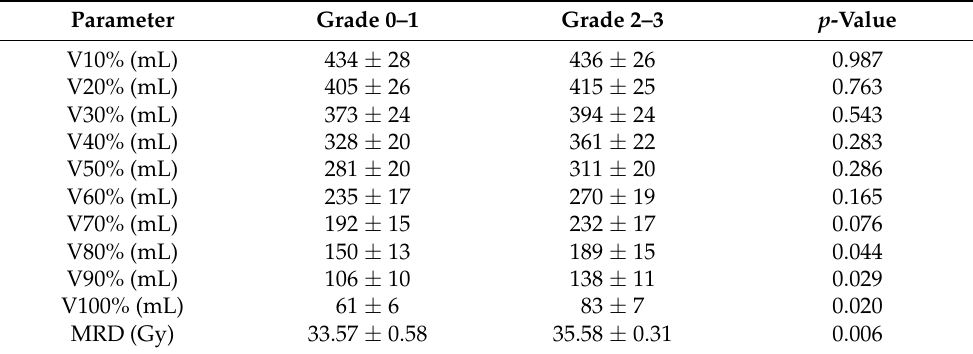
Table 2. Dosimetric data between Grade 0–1 and Grade 2–3